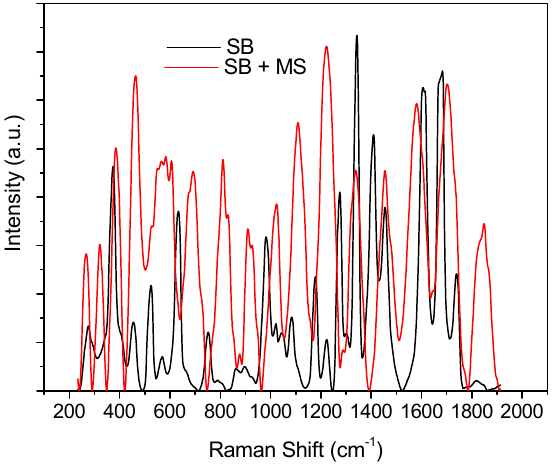
Figure 7. Raman spectra of pure SB solution (black, SB) and SB solution after mild steel immersion (red, SB +